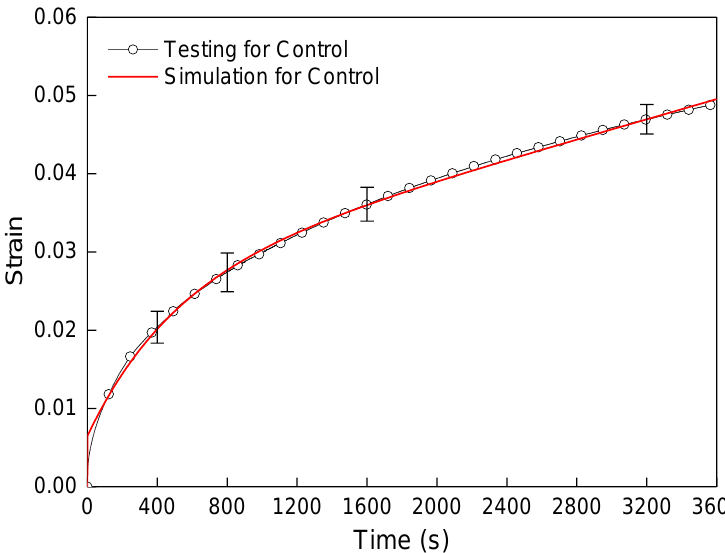
Figure 7. Comparison of flexural–tensile rheological curves for testing and simulation at 3600 s.